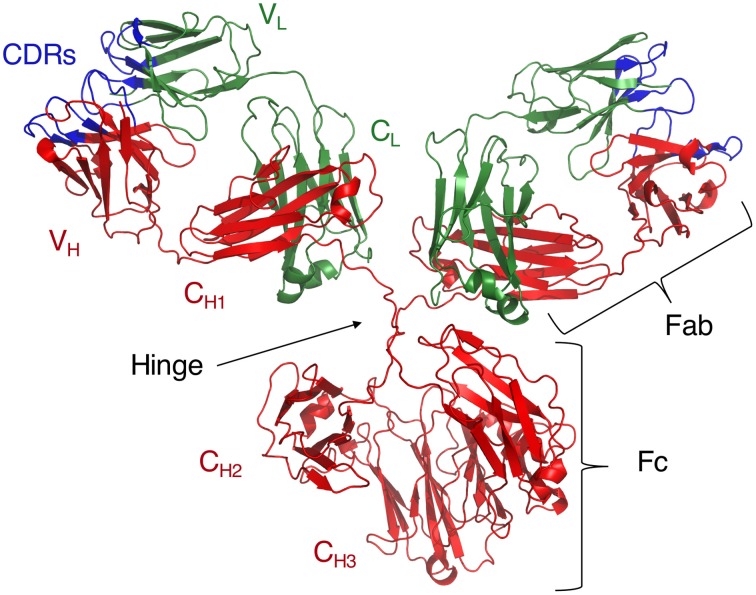
Crystal structure of intact IgG1 (PDB ID: 1IGY). Adapted from Harris et al. (1998).